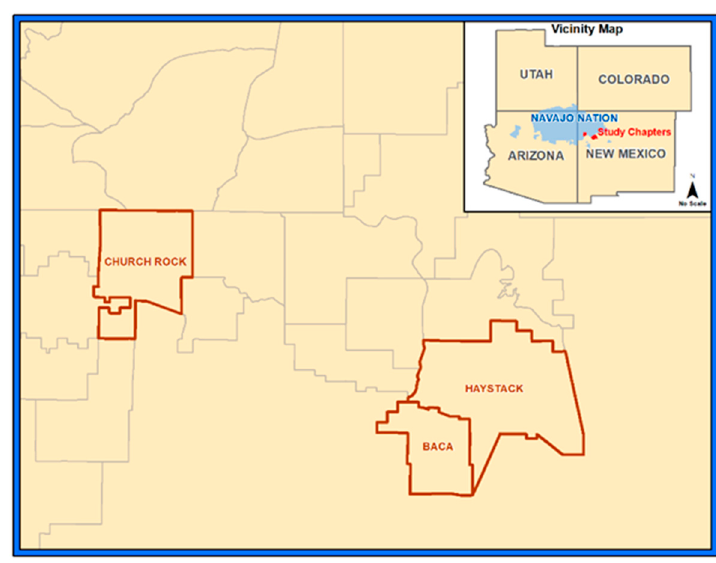
Figure 1. Participating chapters or communities (Churchrock and Baca / Haystack) on the Navajo Reservation in northwestern New Mexico. Inset shows their proximity to the Four Corners region of the USA.